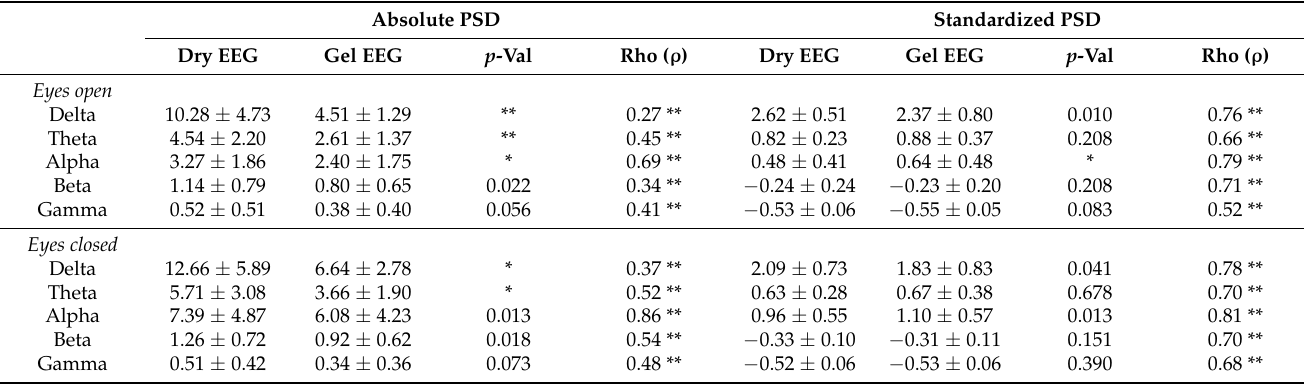
Figure 5. Power spectral density (PSD) of the eyes open/eyes closed task for the gel EEG system (blue) and the dry EEG system (red). ( a ) Absolute PSD ( μ V 2 /Hz) during the period of open eyes (left) and a period of closed eyes (right). ( b ) Standardized PSD (Z-score) during the period of open eyes (left) and a period of closed eyes (right). Lines indicate the average power over all channels and subjects. Shaded areas indicate the confidence interval (mean ± 2xSD). ( c ) The standardized topographic distribution (Z-score) of the alpha band during eyes open (left) and eyes closed (right) for the gel EEG system and the dry EEG system. Black lines in the topographic distribution encircle the pixels that were significantly different between systems. Table 2. Descriptive statistics (mean ± SD) of the absolute ( µ V 2 /Hz) and standardized (Z-score) power spectral density (PSD) per frequency band during the eyes open/eyes closed (EOEC)-task for the dry EEG system and gel EEG system. p -value ( p -Val) after Bonferroni correction as a result of the Wilcoxon signed-rank test and Spearman’s correlation coefficient (rho) are indicated for each frequency band and condition. Absolute PSD Standardized